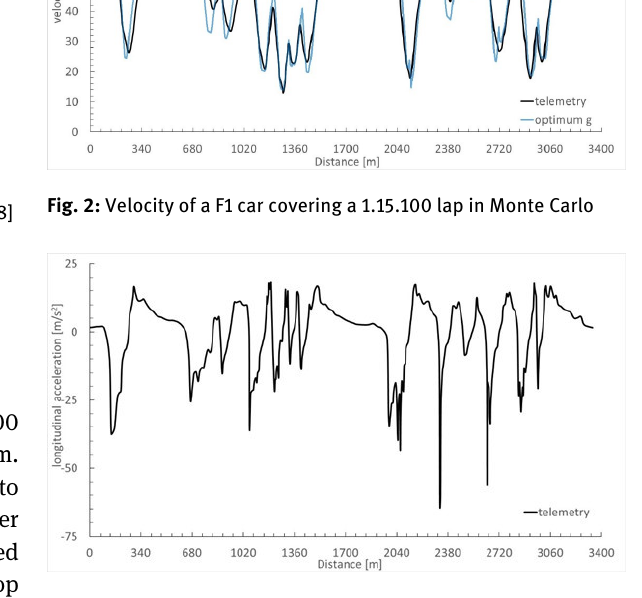
Fig. 3: Acceleration of a F1 car covering a 1.15.100 lap in Monte